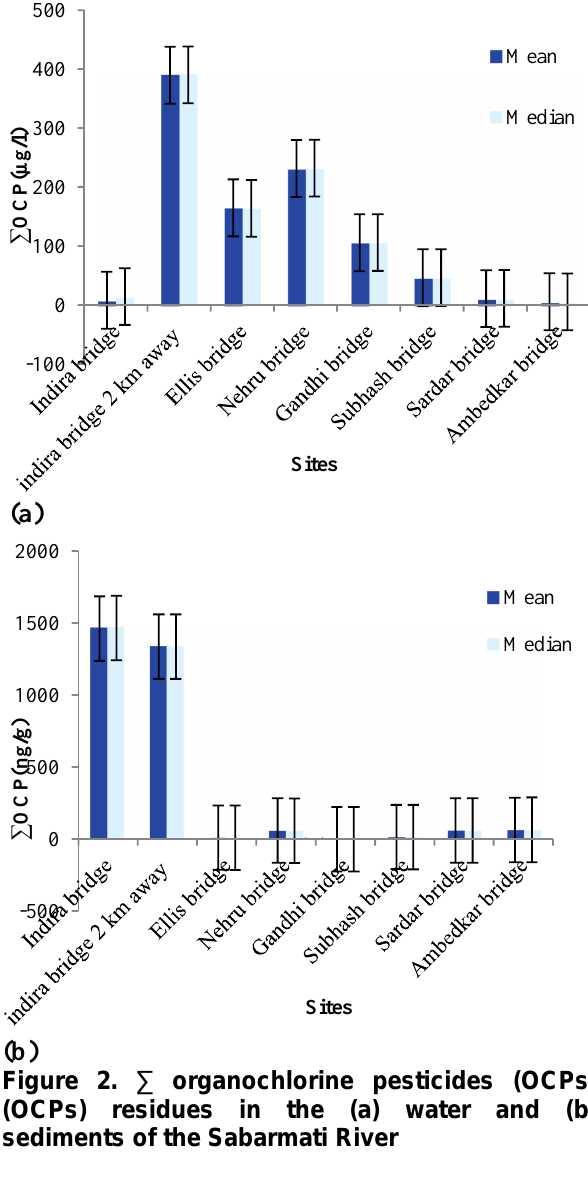
Figure 2. ∑ organochlorine pesticides (OCPs) (OCPs) residues in the (a) water and (b) sediments of the Sabarmati River The concentration of ∑HCH in the Kaveri River ranged from 4.35 to 158.4 ng/g, 12 which